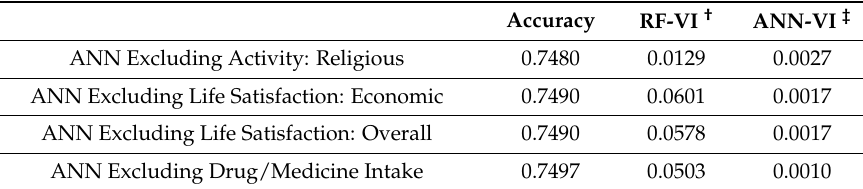
Figure 2. The variable importance from the Random Forest. 4. Discussion